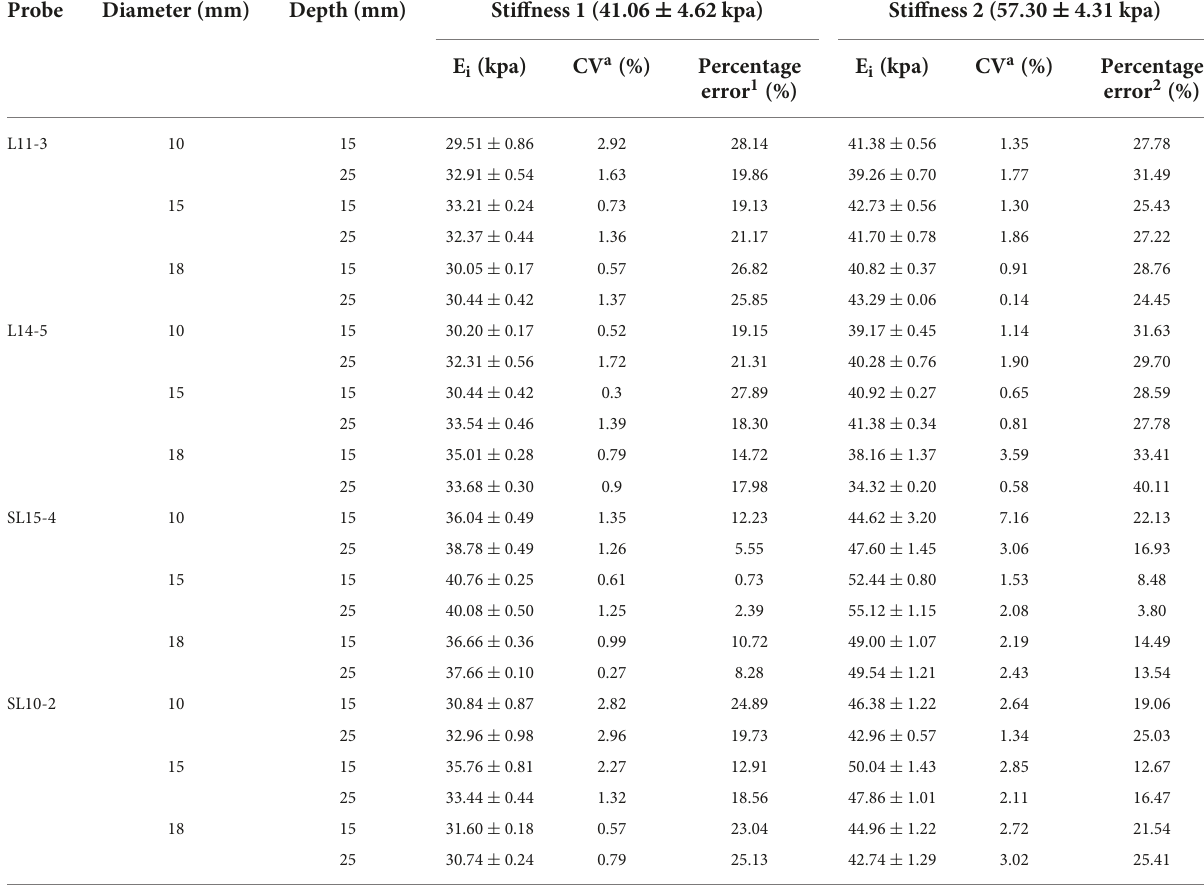
TABLE 1 The shear wave elastography (SWE) measurement values, coefficient of variation, and percentage error obtained using four probes. Probe Diameter (mm)